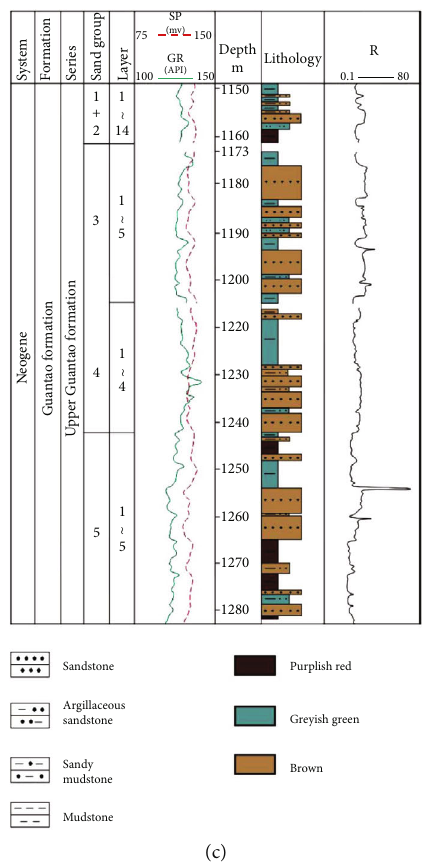
Figure 1: Stratigraphic system and regional location in the north of region M of the Gudao Oil fi eld. (a) Location of the study area. (b) Well pattern in the study area. (c) Comprehensive histogram of the upper member of Neogene Guantao formation in Gudao Oil fi